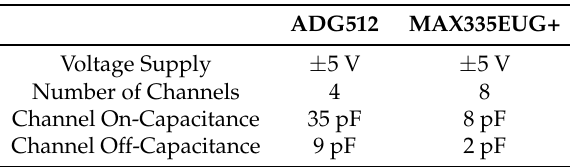
Figure 15. Experimental result of noise reduction efficacy using DTCs. ADG512: 4 tunable steps, about 24 pF for each step; MAX335: 8 tunable steps, about 6 to 8 pF for each step. Table 5. Parameters of ADG512 and